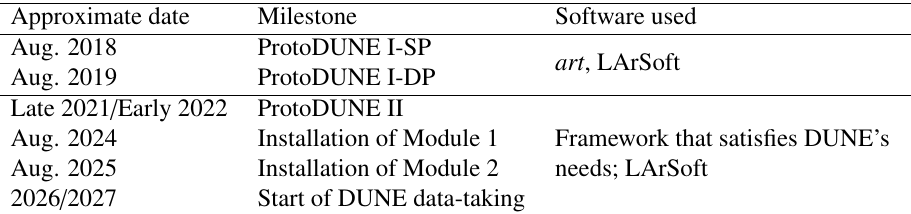
Table 2. Approximate timeline (as of November 2019) for various milestones of the DUNE experiment. The terms “SP” and “DP” refer to single-phase and dual-phase LAr technologies, respectively. Only the software relevant to this talk is